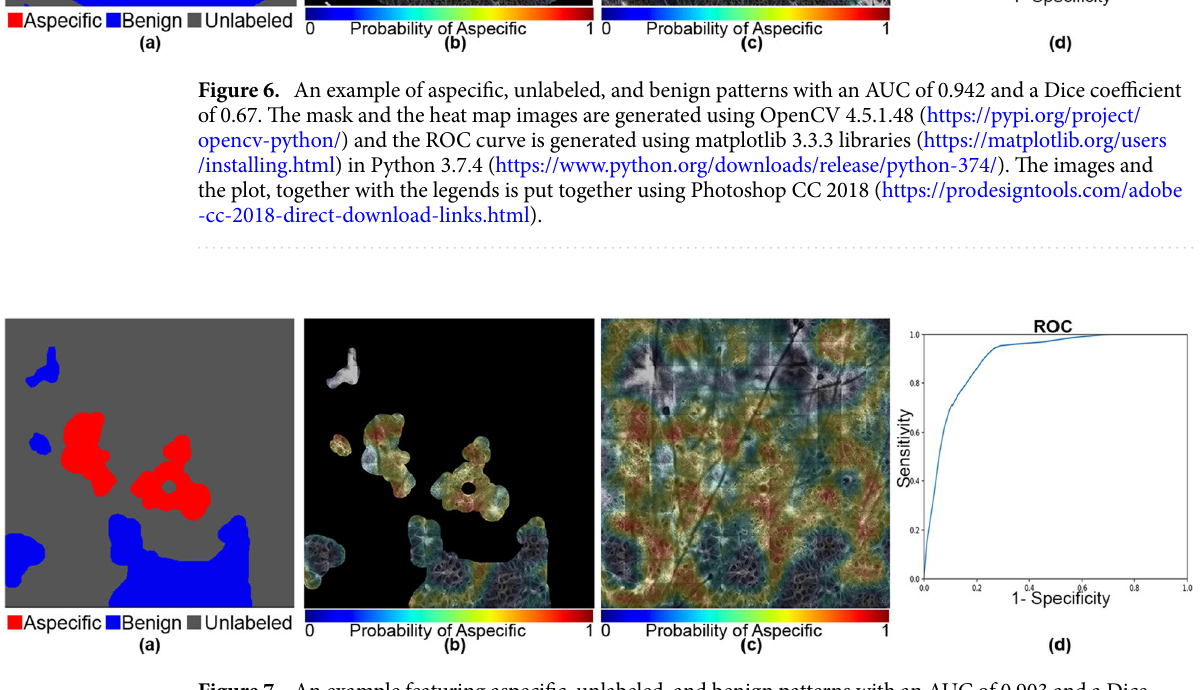
Figure 7. An example featuring aspecific, unlabeled, and benign patterns with an AUC of 0.903 and a Dice coefficient of 0.79. The mask and the heat map images are generated using OpenCV 4.5.1.48 (https ://pypi.org/ proje ct/openc v-pytho n/) library and the ROC curve is generated using matplotlib 3.3.3 libraries (https ://matpl otlib .org/users /insta lling .html) in Python 3.7.4 (https ://www.pytho n.org/downl oads/relea se/pytho n-374/). The images and the plot, together with the legends are put together using Photoshop CC 2018 (https ://prode signt ools.com/adobe -cc-2018-direc t-downl oad-links